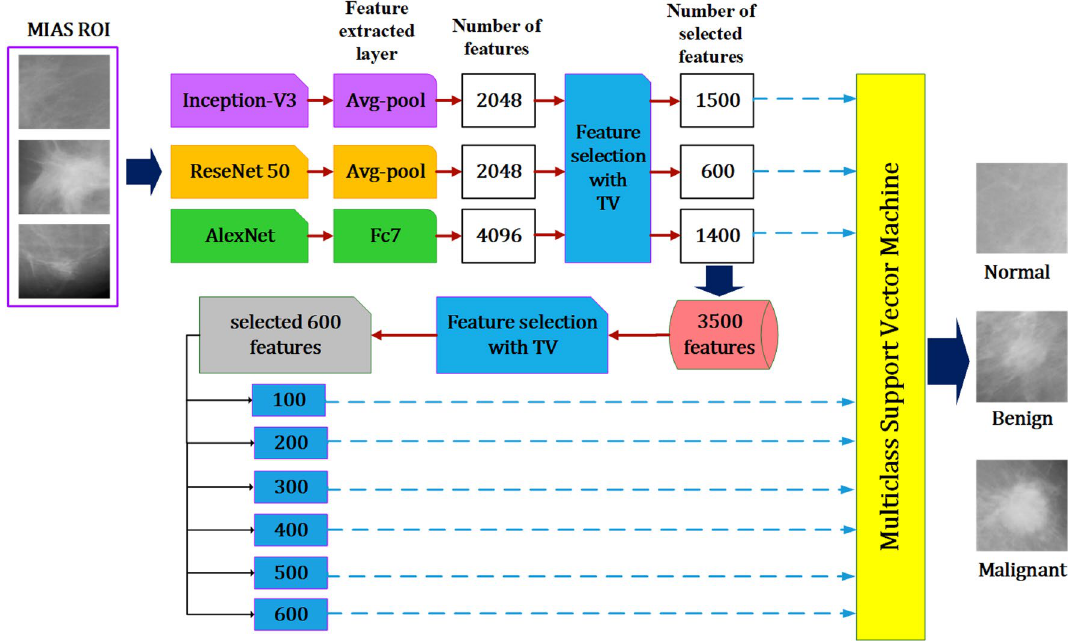
Figure 1. The concept of the suggested